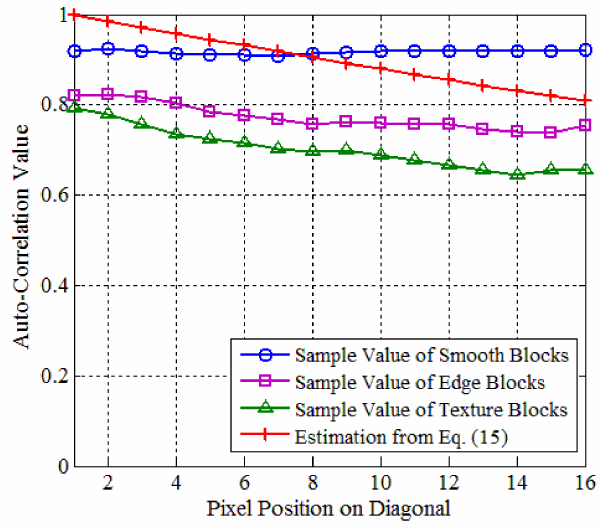
Figure 4. Comparison of sample and estimation of auto-correlation